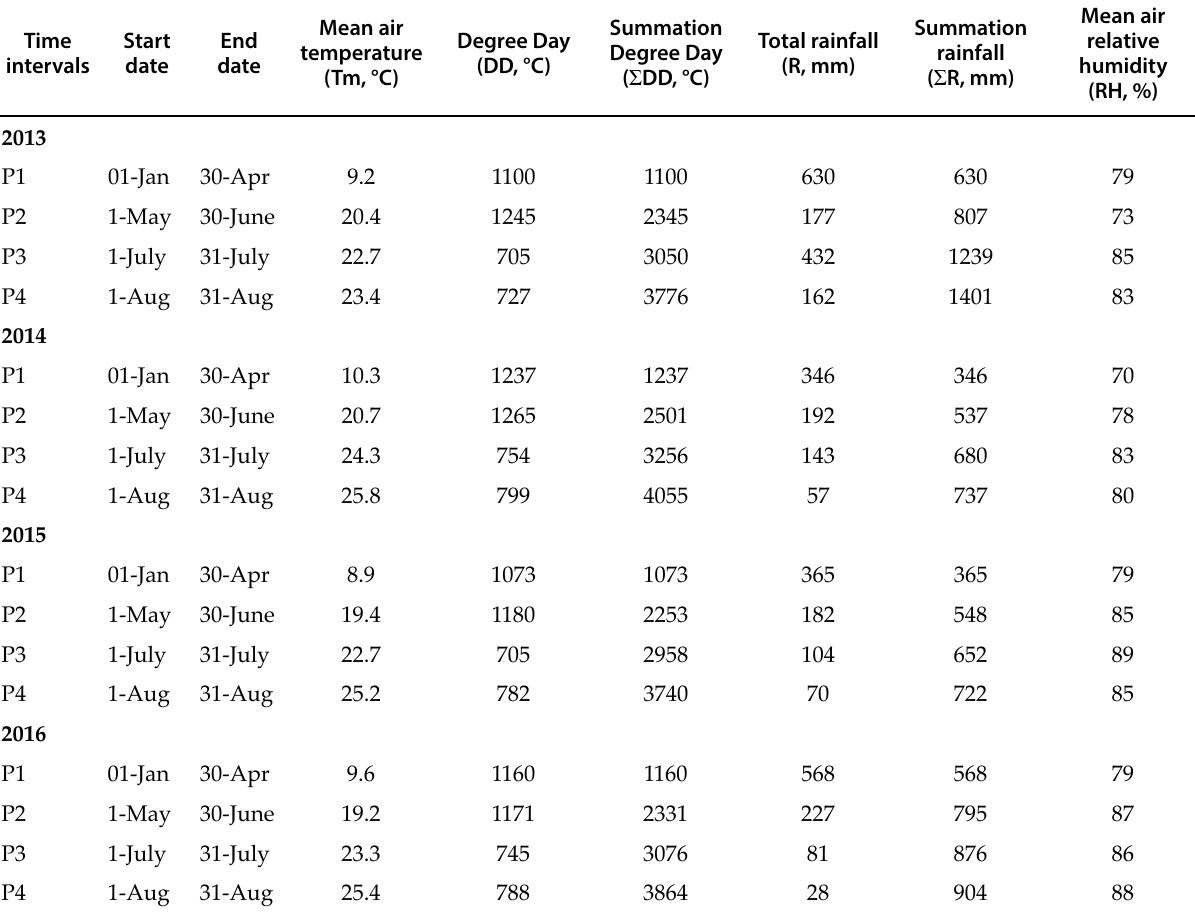
Table 3. Summary of meteorological data collected during the 4 years study (2013 to 2016) at four time intervals (P1-P4) from 1 January to 30 August each year. Data are from a meteorological station situated approx. 500 m from the hazelnut orchard used for the present